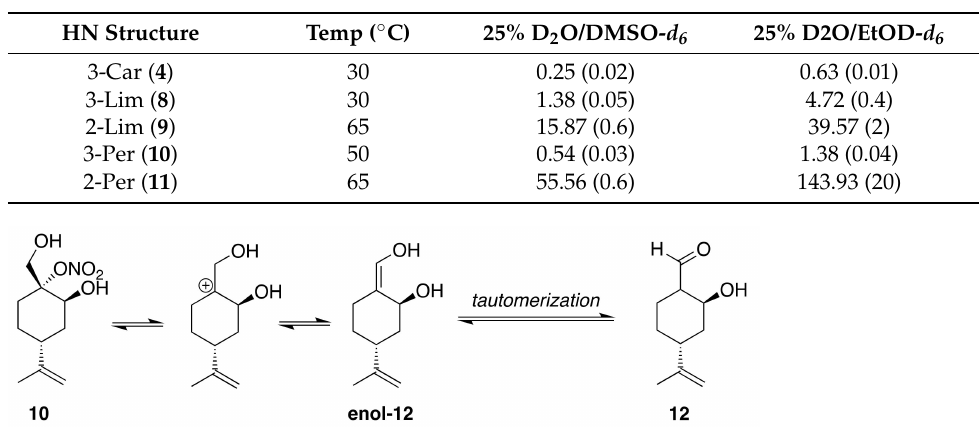
Table 3. Lifetimes (hours) of HN conversion in acidified 25% D 2 O/EtOD- d 6 and 25% D 2 O/DMSO- d 6 . Uncertainties, given in parentheses, represent one standard deviation from triplicate (DMSO) or duplicate (EtOD) measurements.